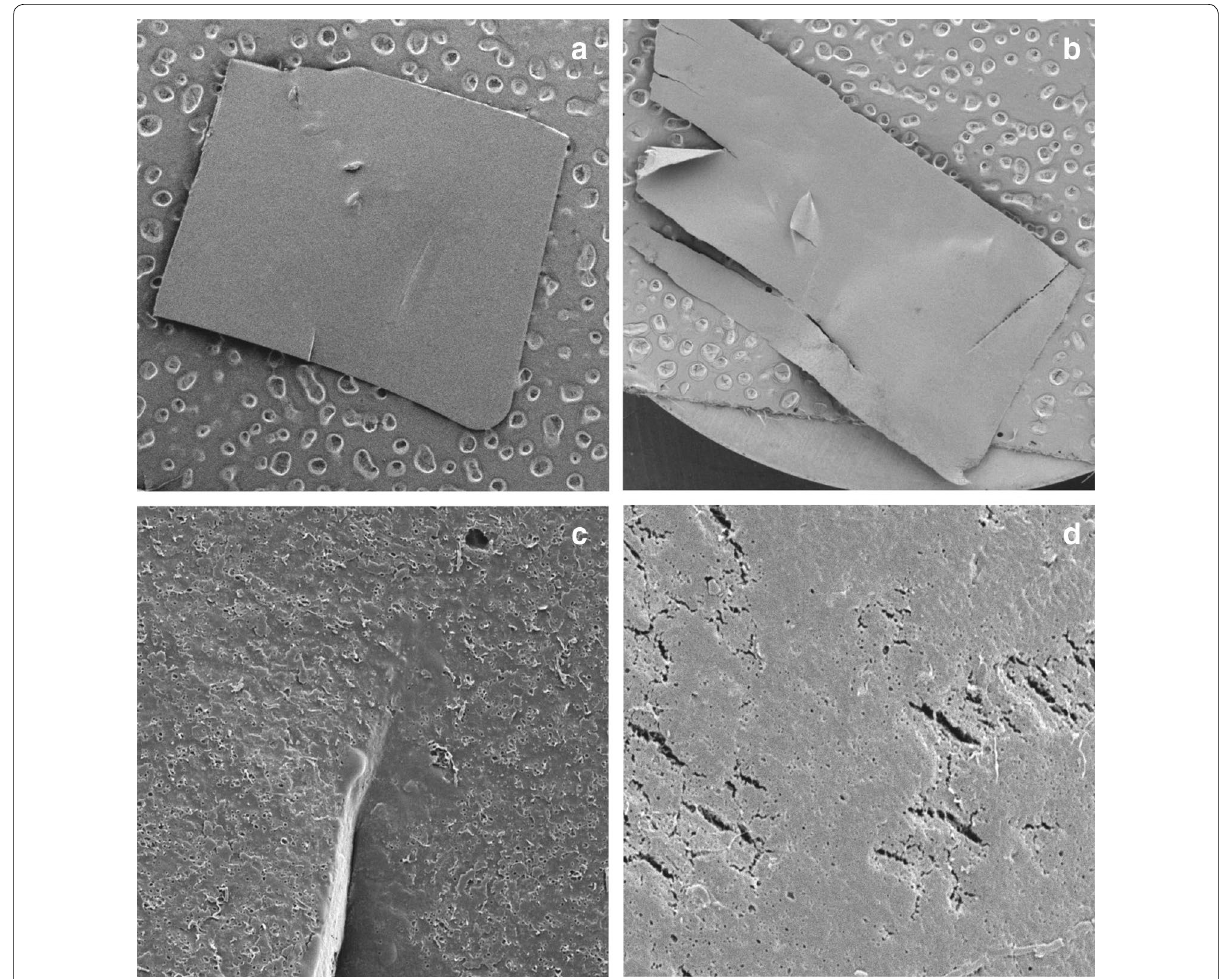
Fig. 5 PCL films at the end of cultivation at 20 °C by C. rosea 16G. The films were viewed by scanning electron microscopy at a 40 magnification ( a , b ) and at a 2000 magnification ( c , d ), as described in “Materials and Methods”. a , c The control; b , d C.